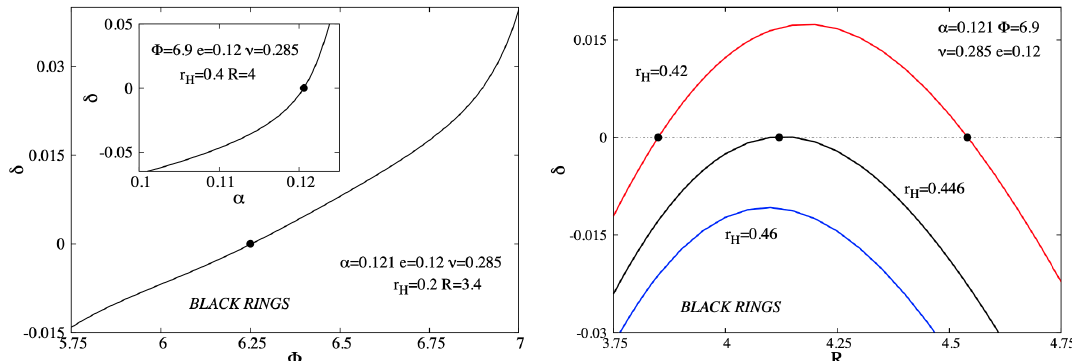
Figure 4 . The conical excess/deficit δ of a static BR in EMgS field theory is shown as a function of the input parameter α which measures the strength of gravity (the inset) and of the electrostatic potential Φ (left panel), and as function of the ring’s radius R (right